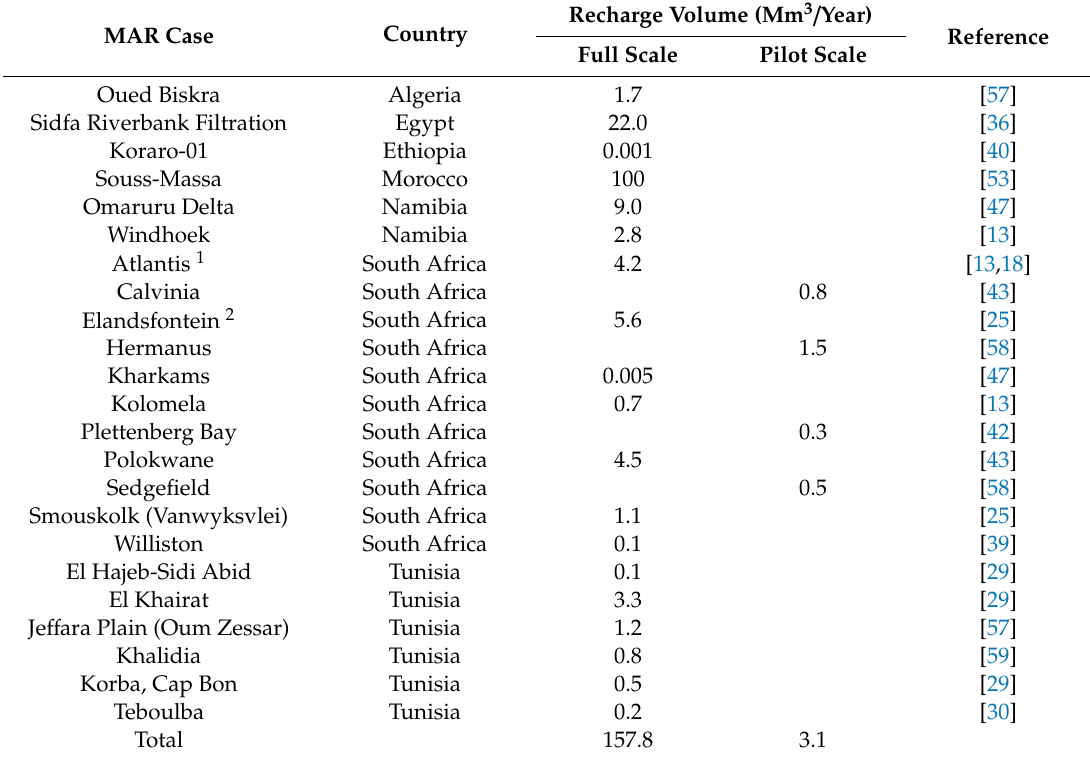
Table 3. Recharge volume per MAR case where information is available (n =